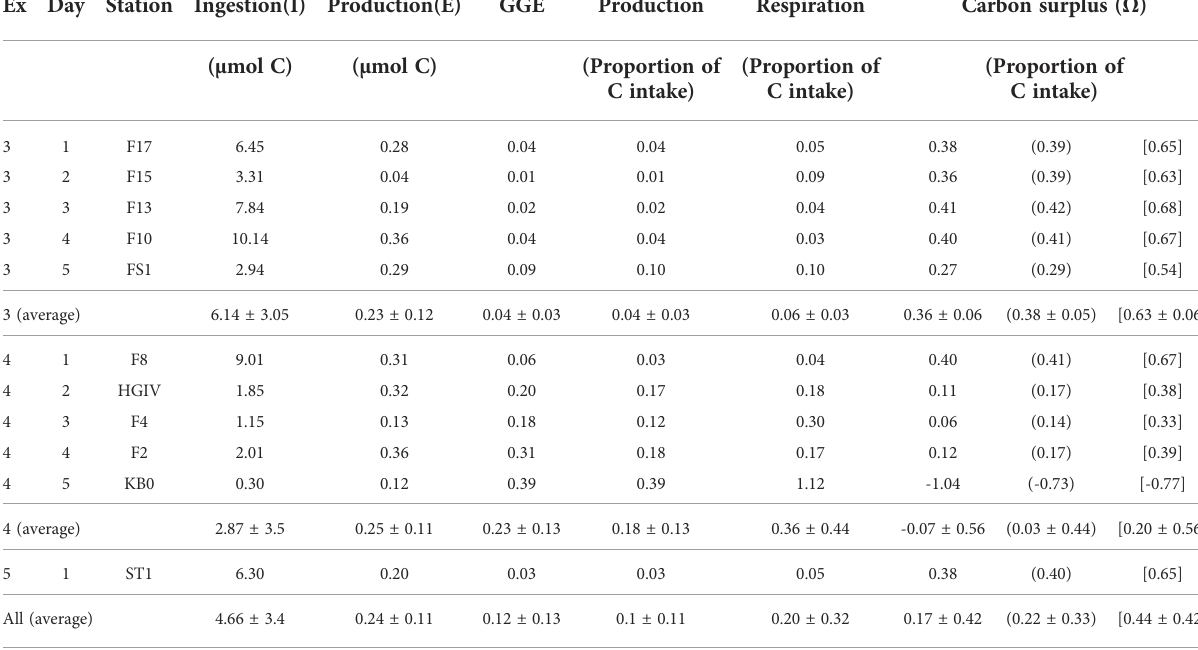
TABLE 3 Daily metabolic carbon (C) budgets for Calanus fi nmarchicus (female -1 day -1 ) [, showing measured ingestion and